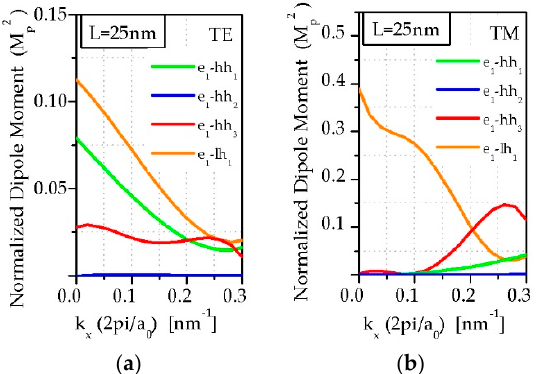
Figure 8. TE ( a ) and TM ( b )—polarized the optical matrix for the InAs/InAs 0.62 Sb 0.32 strain balanced SL for L = 25 nm at T = 230 K.